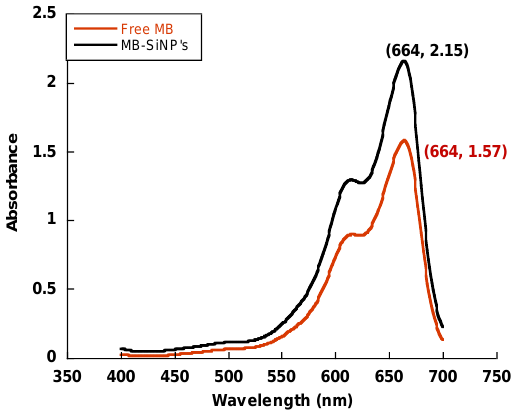
Figure 1. UV-vis spectrophotometer spectrum of naked MB and MB-SiNPs.